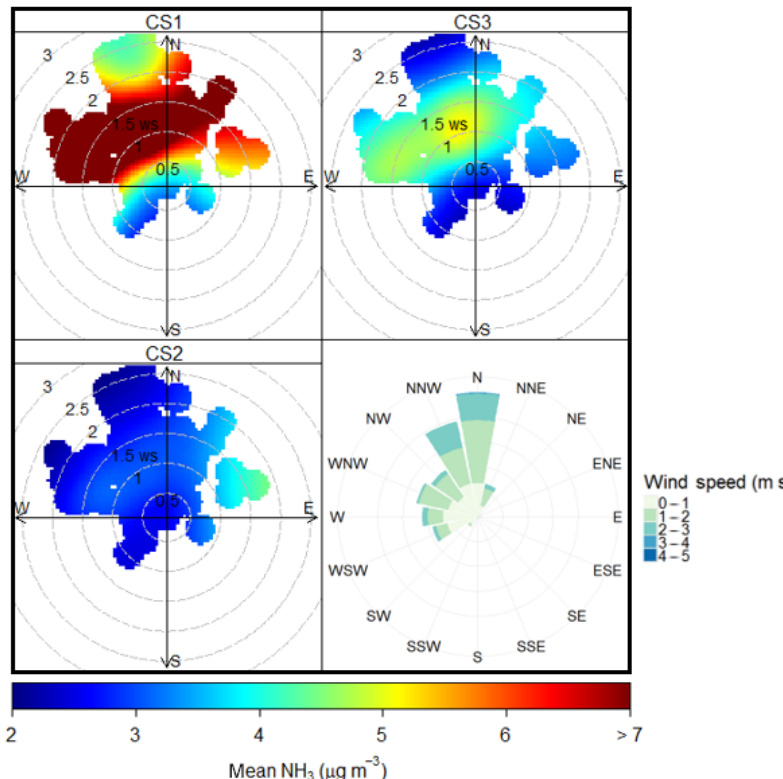
Figure 5. Polar plots showing averaged NH 3 concentrations with wind speed and direction for each DOAS system, with a wind rose showing the prevailing wind directions, Period 2 (20–29